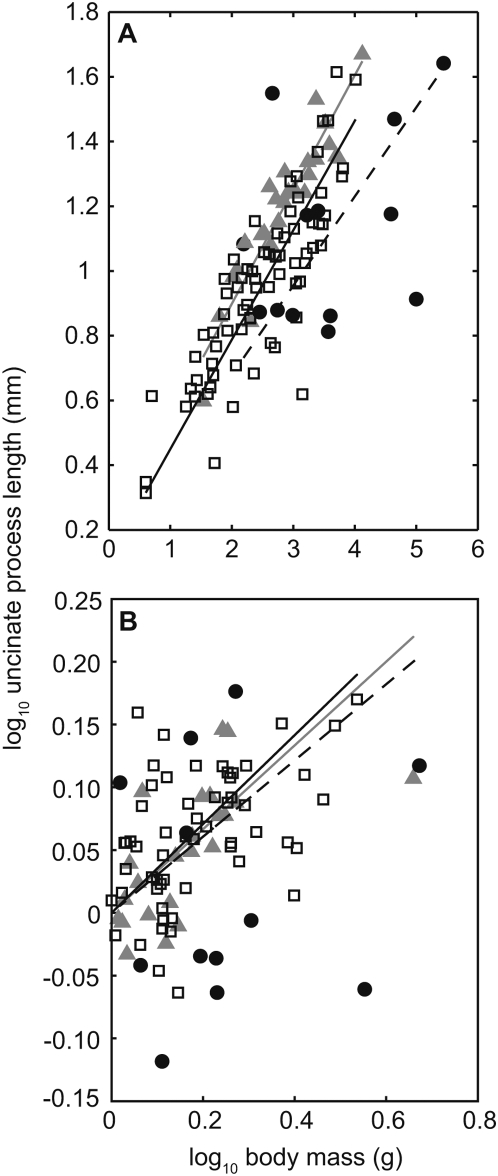
The relationship between uncinate process length (UPL) and body mass (a) species level analysis, b) comparative analysis using independent contrasts and the phylogeny of Livezey and Zusi [31].Diving birds (grey solid triangles and grey regression lines), non-specialists (open squares and black regression lines) and walkers (solid circles and dashed regression lines). The equations describing the lines of best fit were y = 1.96 x
0.35 (0.30−0.41) (t = 12.80, n = 27, r
2 = 0.85, p<0.001) and y = x
0.33 (0.25−0.42) (t = 8.47, n = 23, r
2 = 0.68, p<0.001) for diving birds, y = 1.29 x
0.34 (0.29−0.38) (t = 14.94, n = 72, r
2 = 0.71, p<0.001) and y = x
0.35 (0.30−0.41) (t = 12.47, n = 57, r
2 = 0.63, p<0.001) for non-specialists, and y = 1.34 x
0.28 (0.07−0.48) (t = 2.99, n = 13, r
2 = 0.15, p<0.02) and y = x
0.30 (0.12−0.49) (t = 3.57, n = 12, r
2 = 0.06, p<0.005) for walkers in a & b respectively.